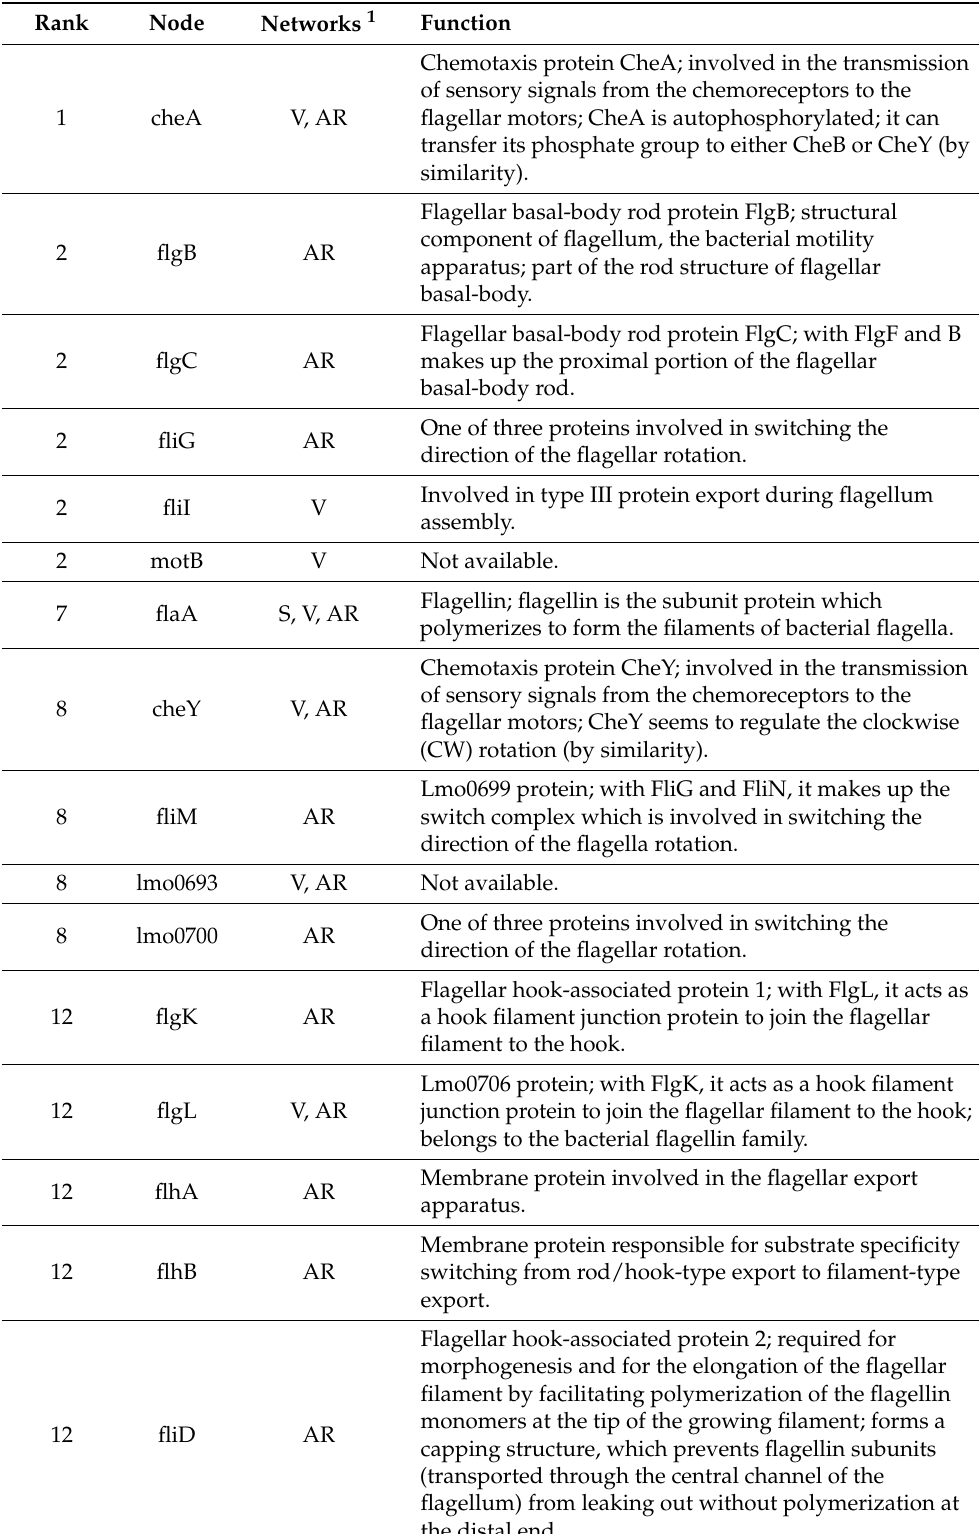
Table A7. Summary of top 21 nodes for the combined